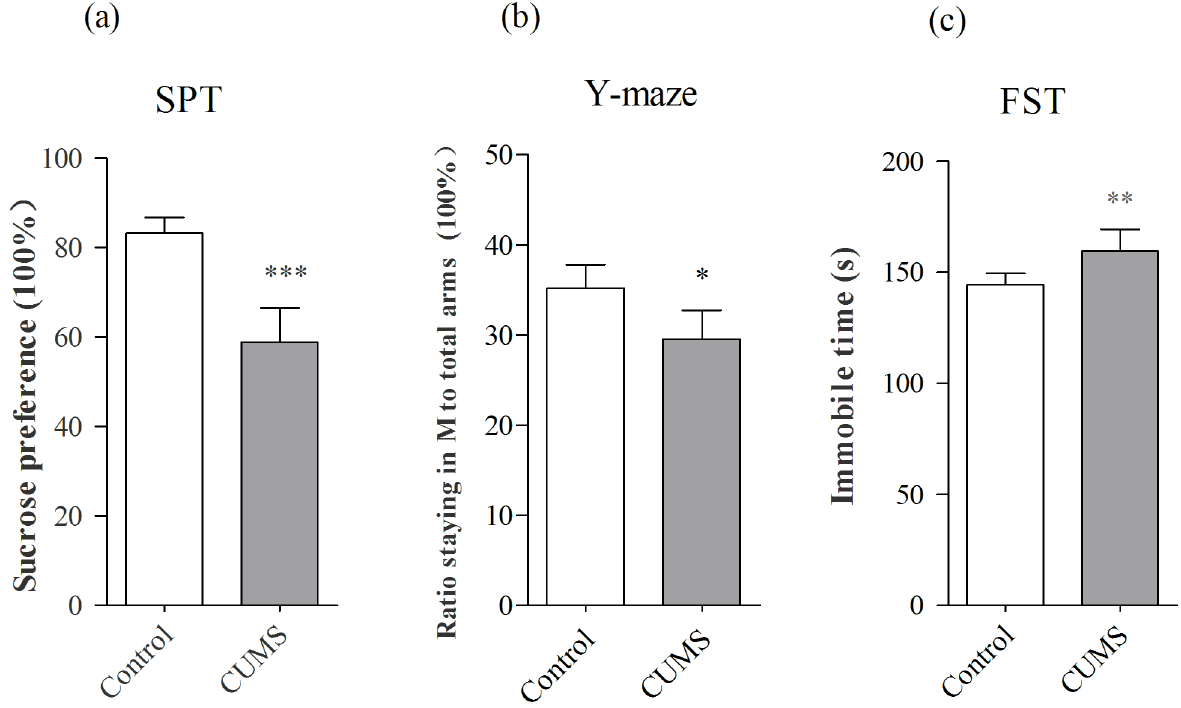
Fig 1. Chronic unpredictable mild stress (CUMS) leads the mice to express depression-like behaviors. Mice were subjected to the adaptation for a week, the CUMS for three weeks and the behavioral tests in three days. Behavior tests showed the significant decreases in sucrose preference (a) and the ratios of stay time in M-arm to stay time in three arms (b) as well as the increase in immobile time (c) from CUMS-induced depression mice (n = 10) and controls (n = 11). The results are expressed as mean ± SEM. * p < 0.05, ** p < 0.01, *** p <